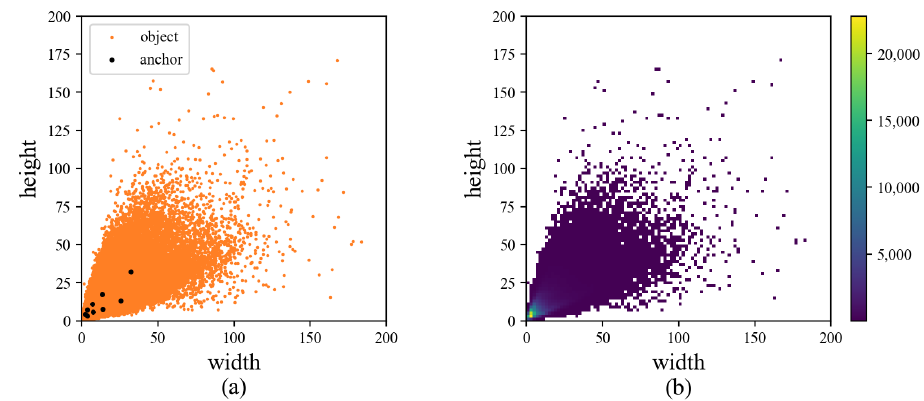
Figure 1. ( a ) The distribution of objects and generated anchors in the Vision Meets Drone (VisDrone) dataset. ( b ) The number of objects with different widths and heights in the VisDrone